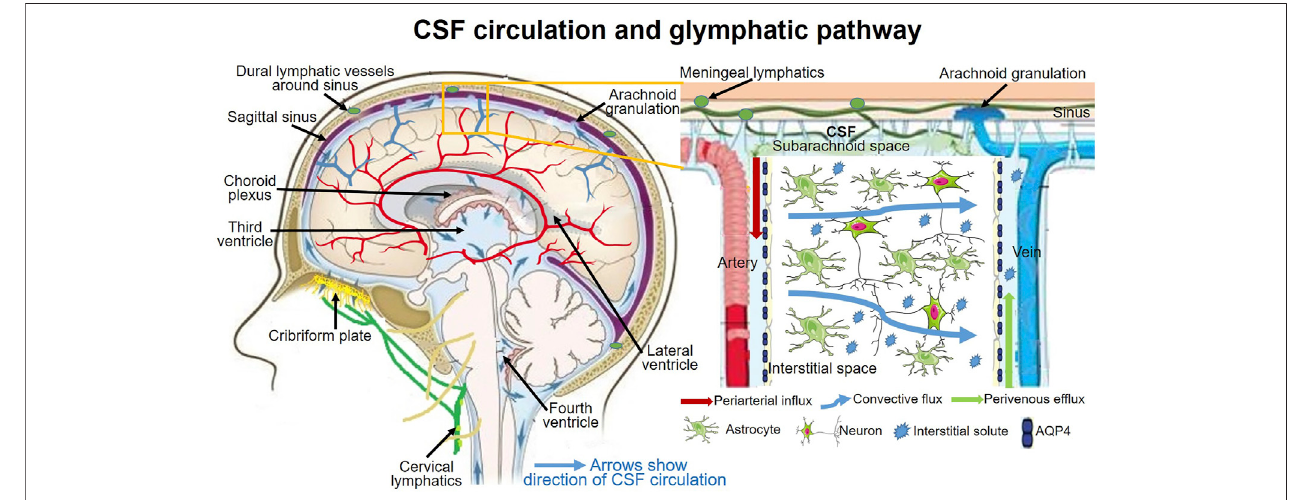
FIGURE 2 | CSF circulation and glymphagitc